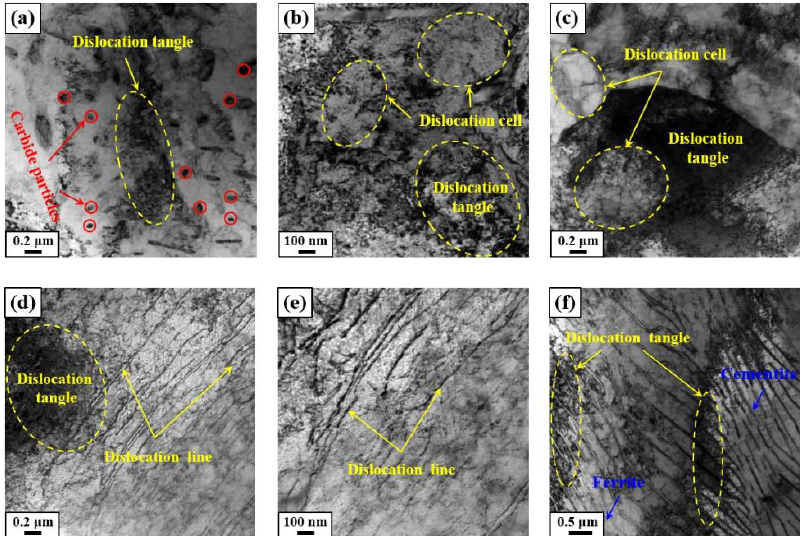
Figure 8. In-depth microstructural TEM observation in the near-surface layer of 40CrMo steel subjected to LSP. ( a – c ) at a depth of 100 µ m, ( d , e ) at a depth of 300 µ m, ( f ) at a depth of 500 µ m.